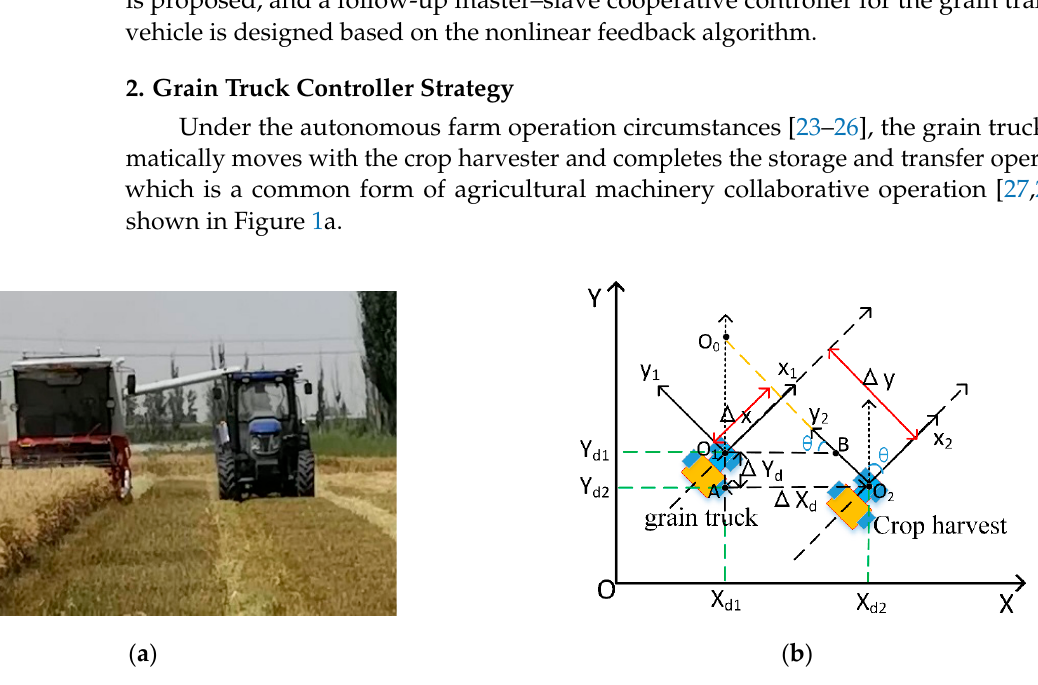
Figure 1. Cooperative operation of agricultural machinery and transformation of vehicle coordinate system. ( a ) Cooperative operation of agricultural machinery; ( b ) Transformation of coordinates.